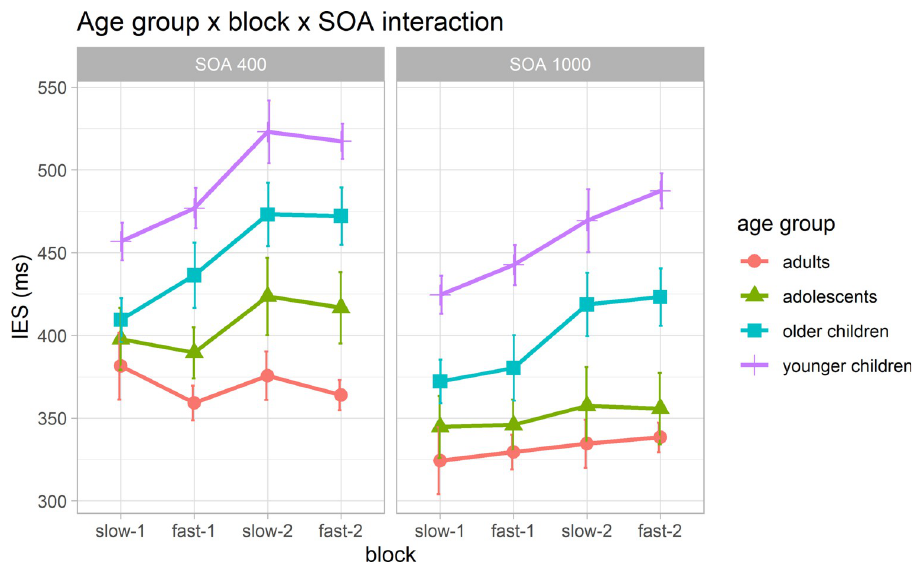
Fig 2. Age group × block × SOA interaction plot on Inverse Efficiency Score (IES) (ms). The panels show the block- by-block changes in response speed for short (left panel) and long (right panel) preparatory intervals (SOA). Only for short SOA trials we found an age-dependent motor adaptation, with adults and adolescents showing faster RTs as the task speeded up. In the case of long-SOA trials all participants showed a general block-by-block RTs trend with progressively slower RTs regardless of the global predictive context (block-type). Error bars represent standard error ( SE ). https://doi.org/10.1371/journal.pone.0281417.g002 Post-hoc contrasts decomposing the age group × SOA interaction showed that in trials with short SOA intervals (see Table 3), as hypothesized (H2b), we found an age-dependent effect of the behavioral adaptation, with older groups performing better than the younger ones.